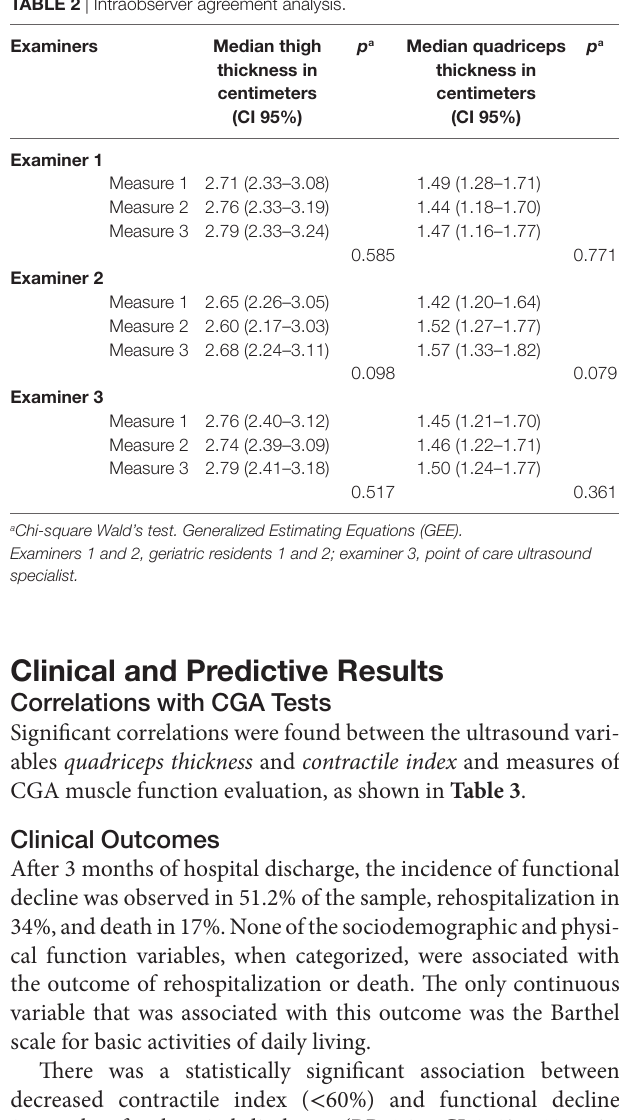
TaBle 2 | Intraobserver agreement analysis. TaBle 1 | Baseline characteristics of studied